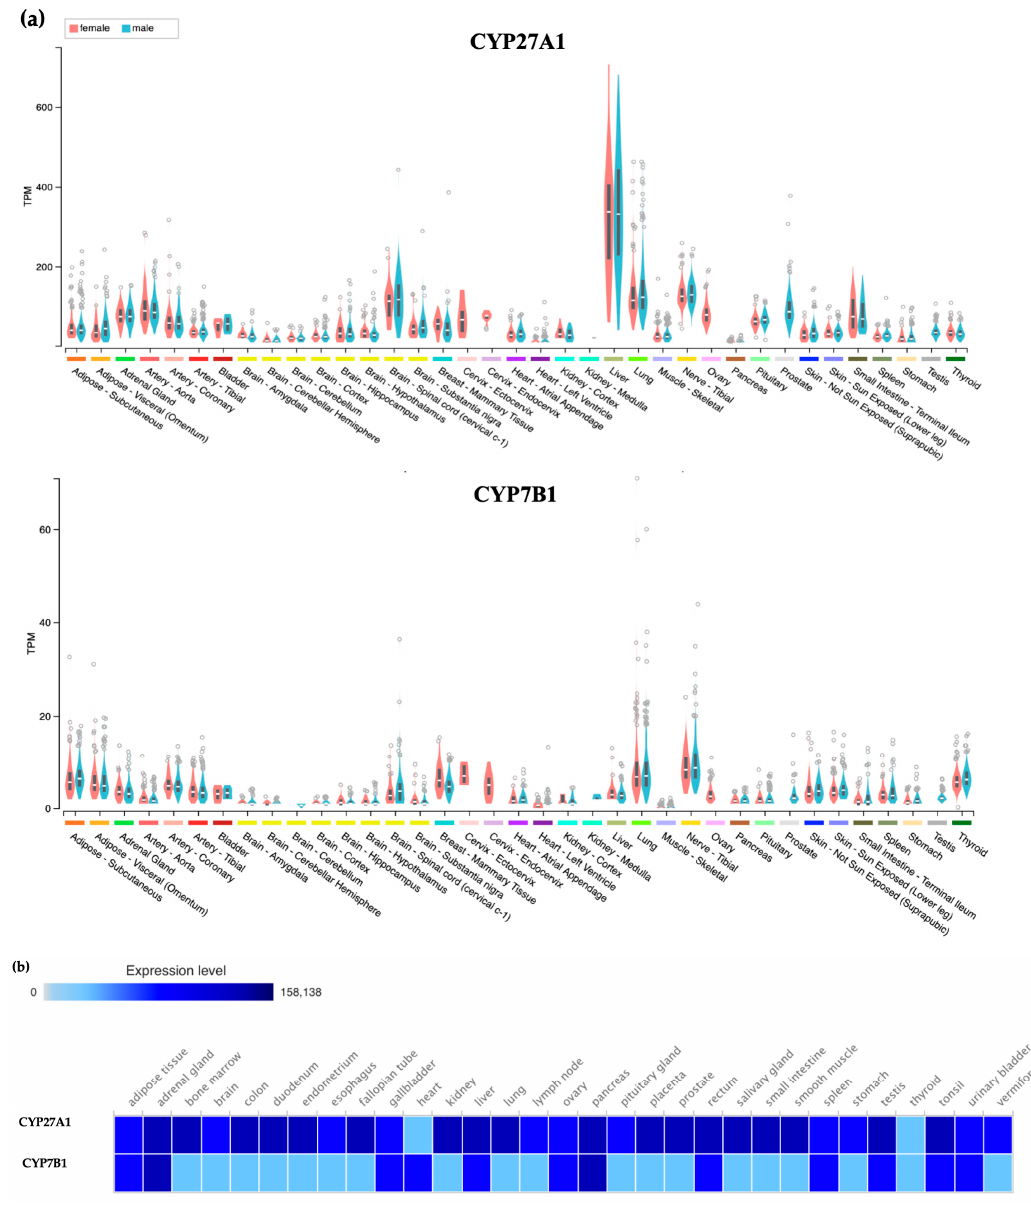
Figure 1. Expression Patterns of CYP27A1 and CYP7B1 in humans. ( a ) The gene expression of CYP27A1 and CYP7B1 . The expression data were based on the RNA expression data obtained from more than 1000 individuals. The results were obtained from the GTEx Portal. ( b ) The expression of CYP27A1 and CYP7B1 proteins. The expression data of these enzyme protein levels were obtained from the work of Wang et al. which categorized the proteome data of 29 healthy human tissues [19]. The visualization of the results was done via Expression Atlas [20].